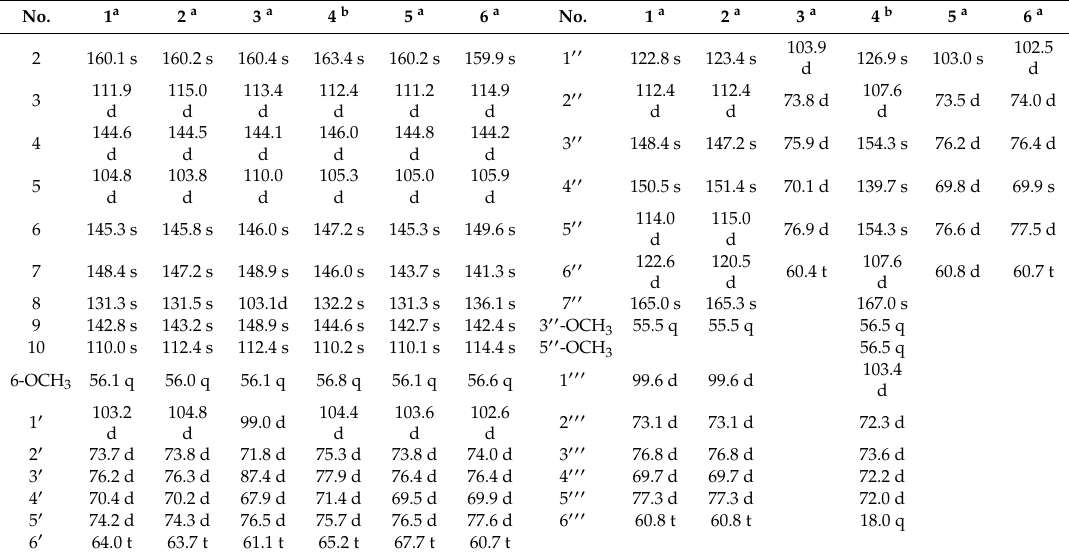
Table 2. 13 C NMR Spectroscopic Data (100 MHz) of 1 – 6